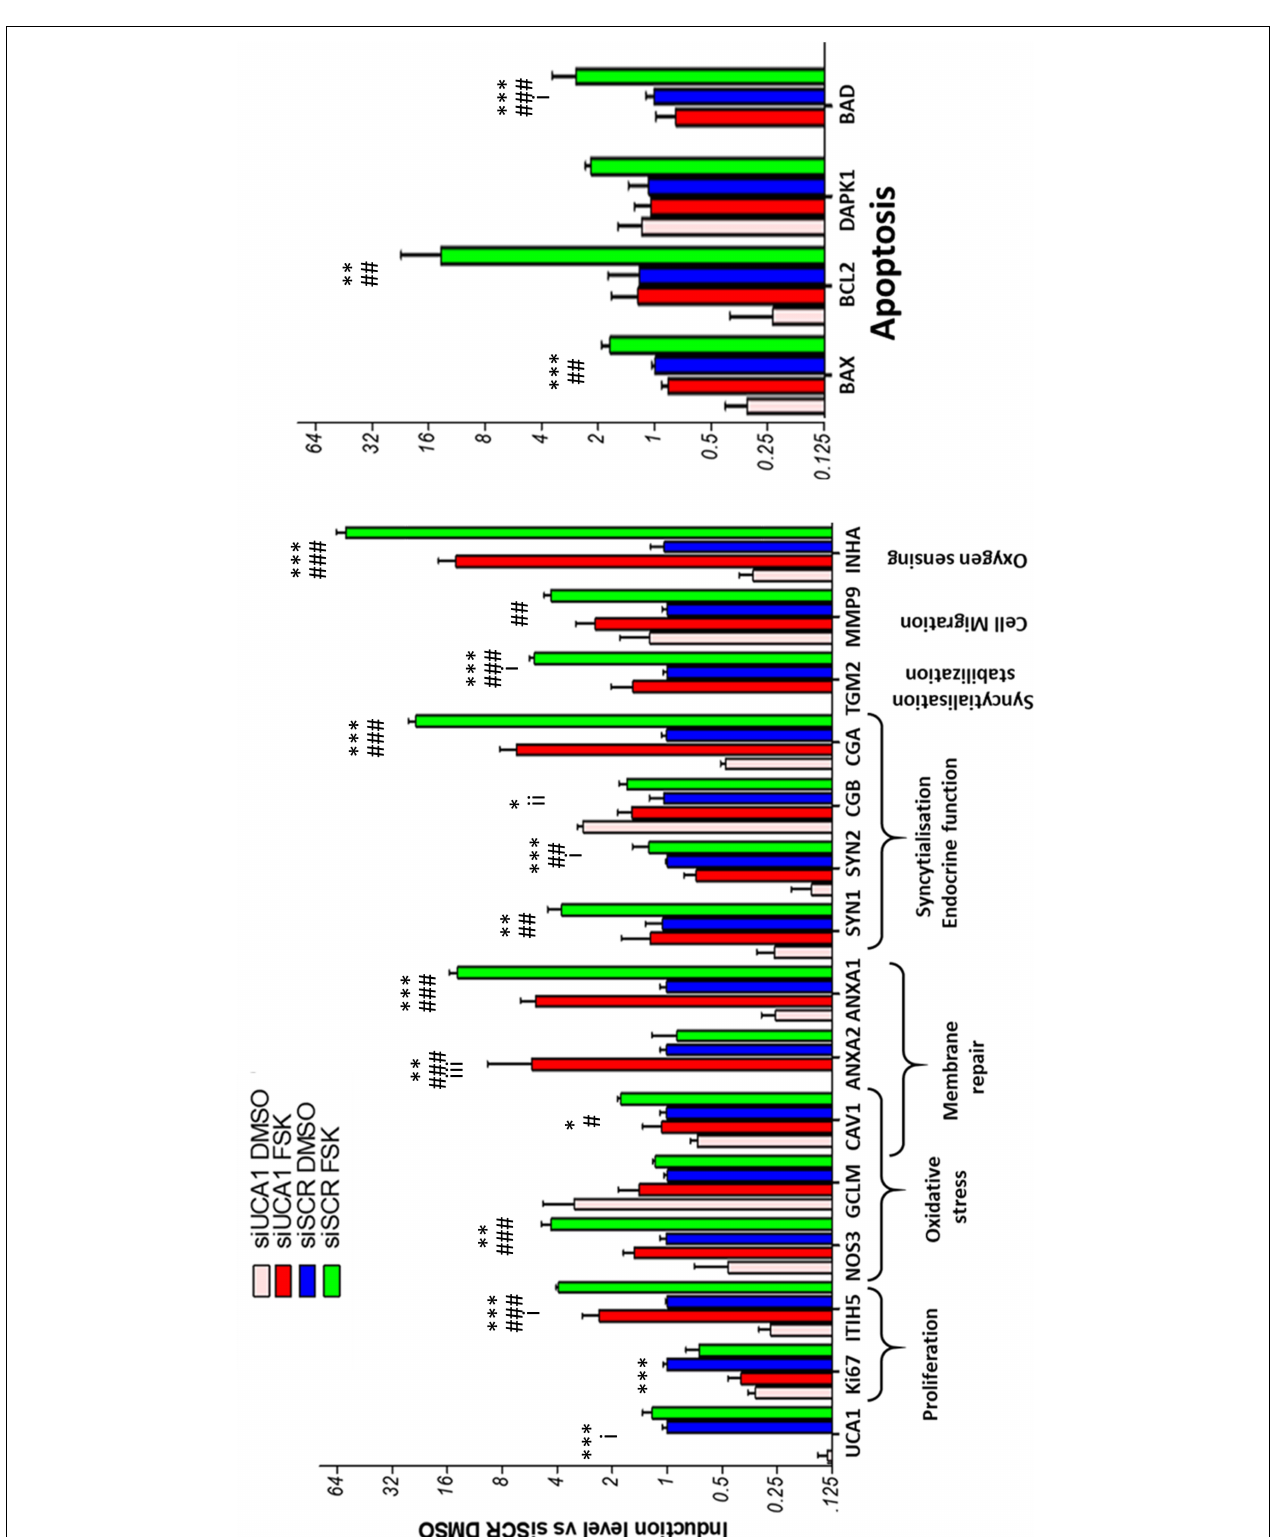
FIGURE 6 | qRT-PCR analysis of the efficiency of UCA1 silencing in BeWo cells with or without forskolin treatment, and its effects on several markers of syncytialization. Genes involved in apoptosis are on the right panel. Stars (*) are marks of a significant effect of the siRNA against UCA1, hashes (#) are marks of significant effects of the forskolin-induced fusion, and (i) are marks of interaction effects (*, # , i represent p -values below 0.05; **, ## , ii p < 0.01; ***, ### , iii p < 0.001).